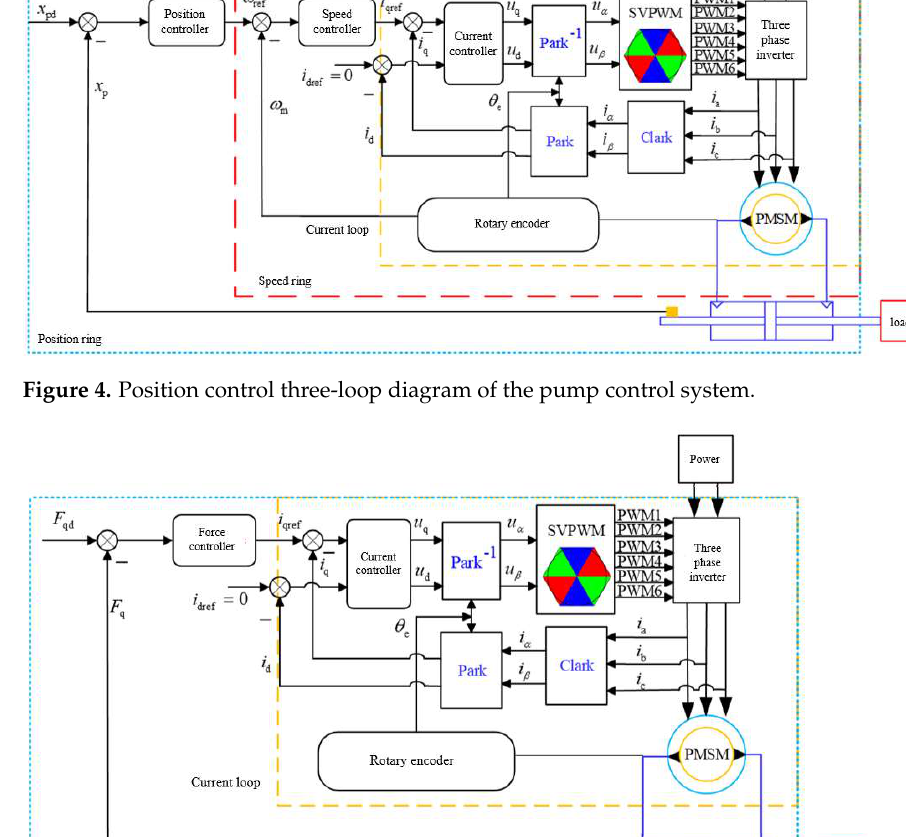
Figure 4. Position control three-loop diagram of the pump control system.